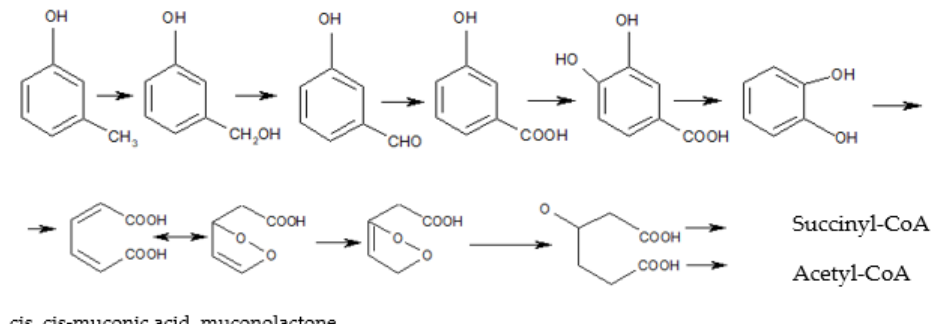
Figure 1. Cresol biodegradation pathway along the ortho (catechol) pathway [23]. Denitrification microorganisms that reduce sulphates are responsible for the anaero- bic catabolism of cresol [24]. An important initiating enzyme is p -cresol methylhydrox- ylase (PCMH) (WE.1.17.99.1), which has been previously isolated from Geobacter metal- lireducens [25].